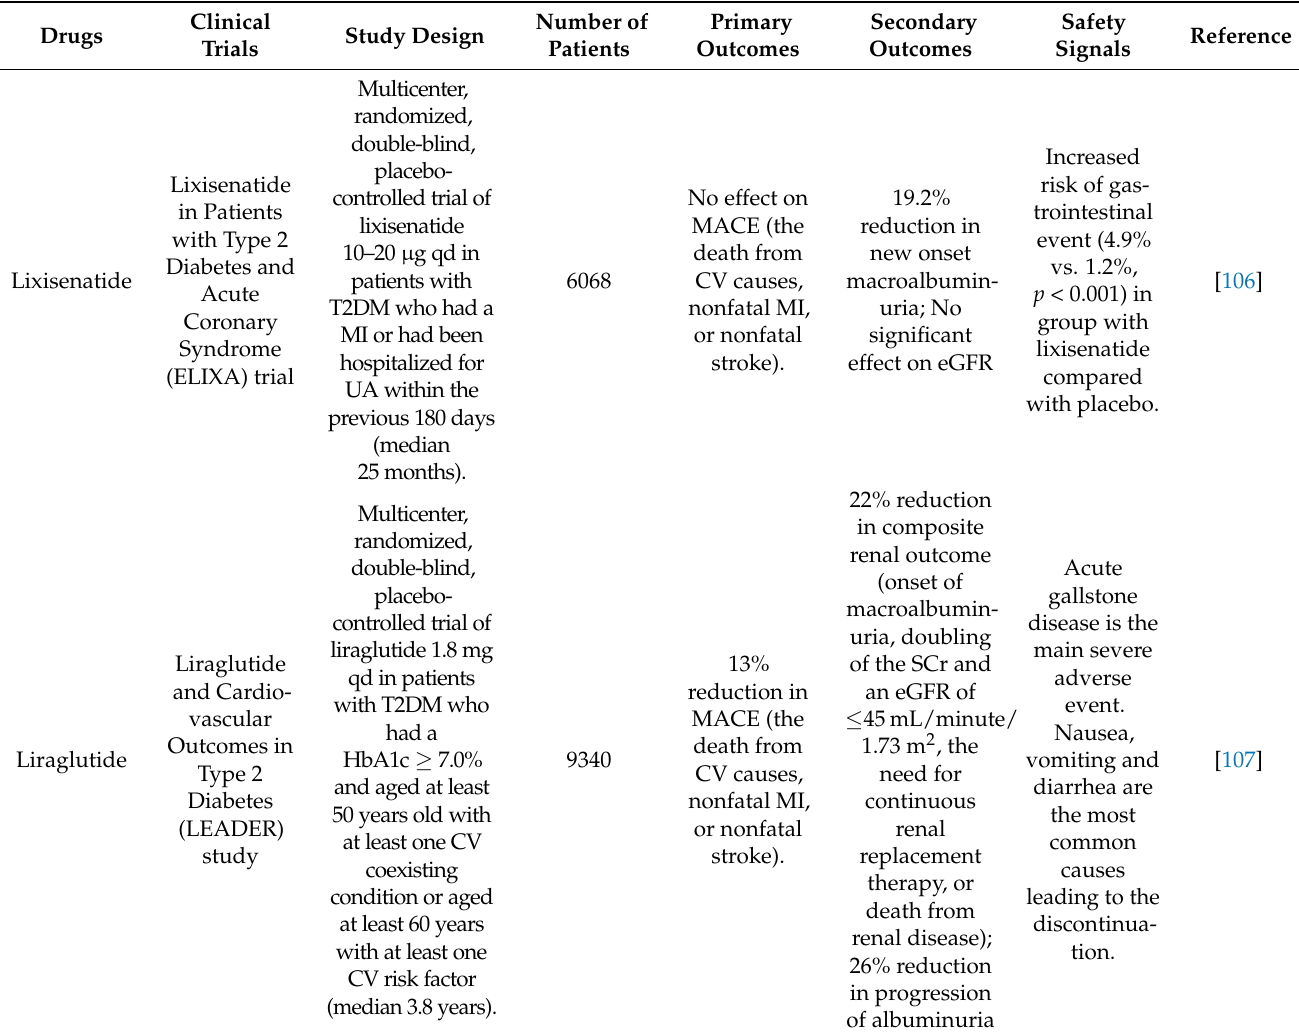
Table 3. Major clinical studies related to GLP-1R